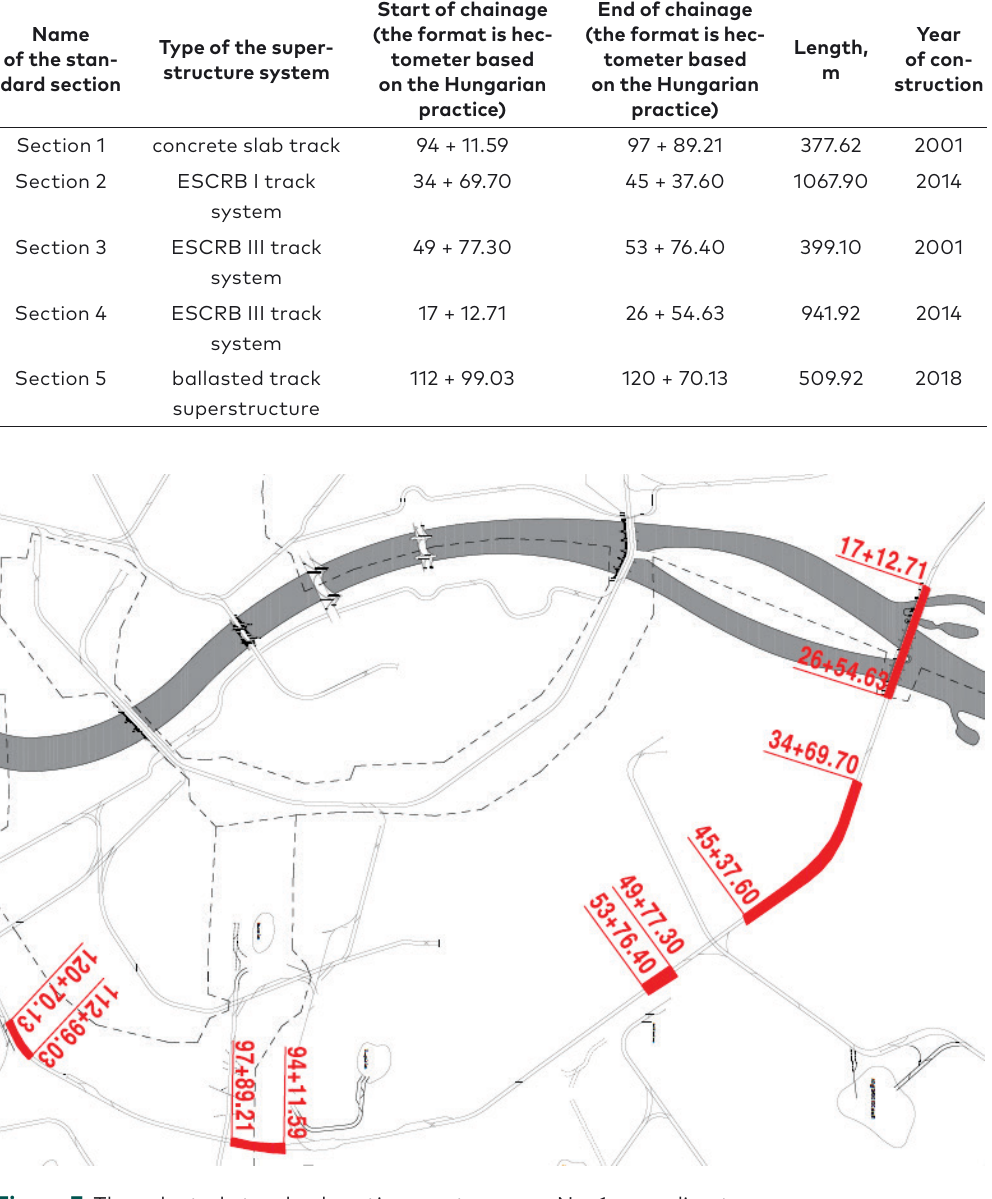
Figure 7. The selected standard sections on tramway No. 1 according to